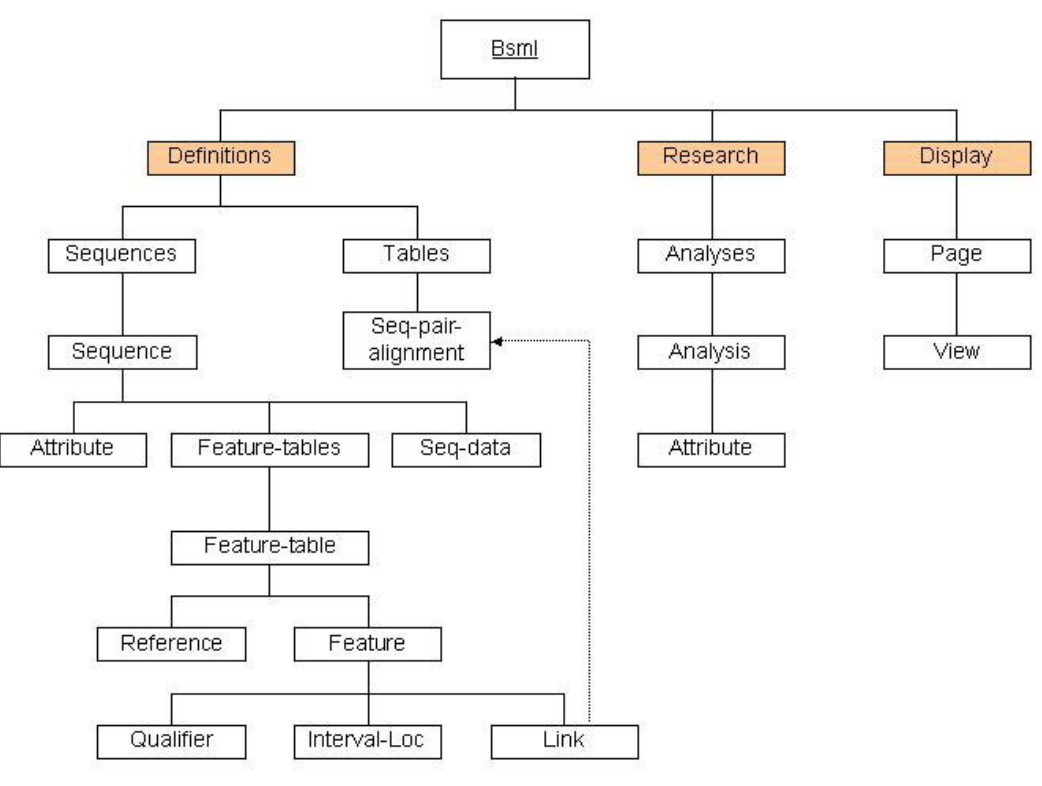
Fig. 3. Basic structure of BSML-documents. Shown are the most important elements which are also used in MyBSML Studio 2003. All Data for a sequence are stored in a "Sequence"-element which again is split into three equal parts: "Definition", "Research" und "Display".